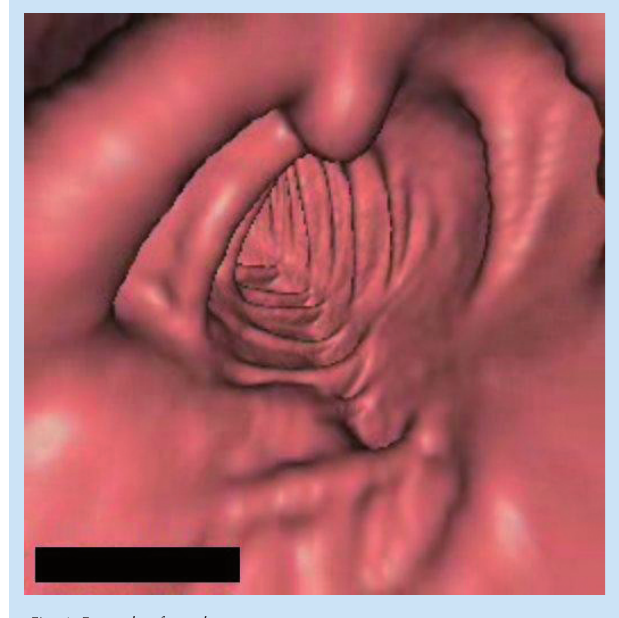
polyp.Fig. 2. Example of irregular mucosa.